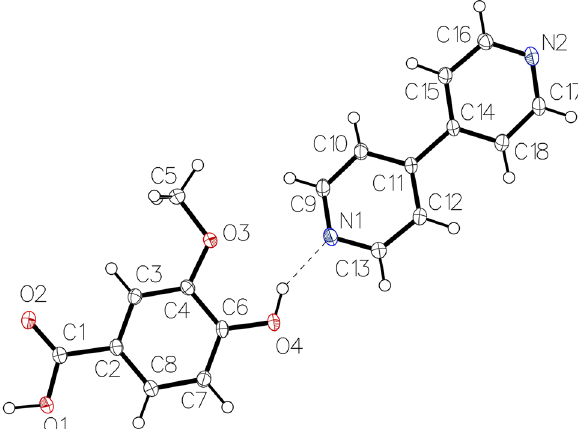
Table  : Data collection and